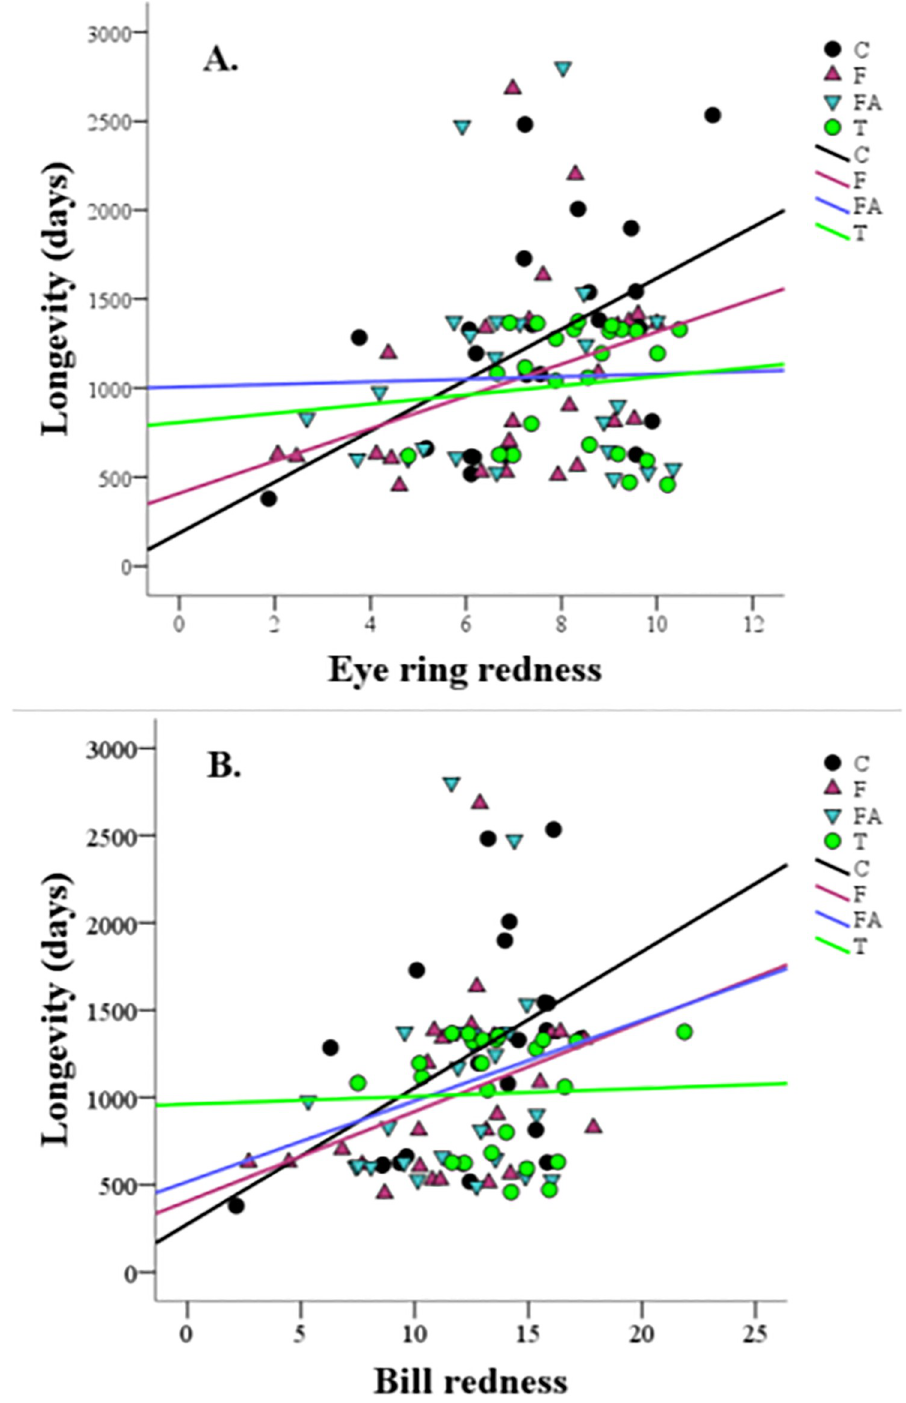
Fig 1. Relationship between longevity and eye ring (A) or bill (B) redness in male partridges with different hormonal treatments. Redness was measured before the first breeding opportunity. Slopes were obtained from ordinary least squares linear regressions. However, Cox regression slopes should be considered (see Results and Tables 1 and 2). Control (C), flutamide (F), flutamide plus ATD (FA) and testosterone (T) treatments. Censored data were excluded